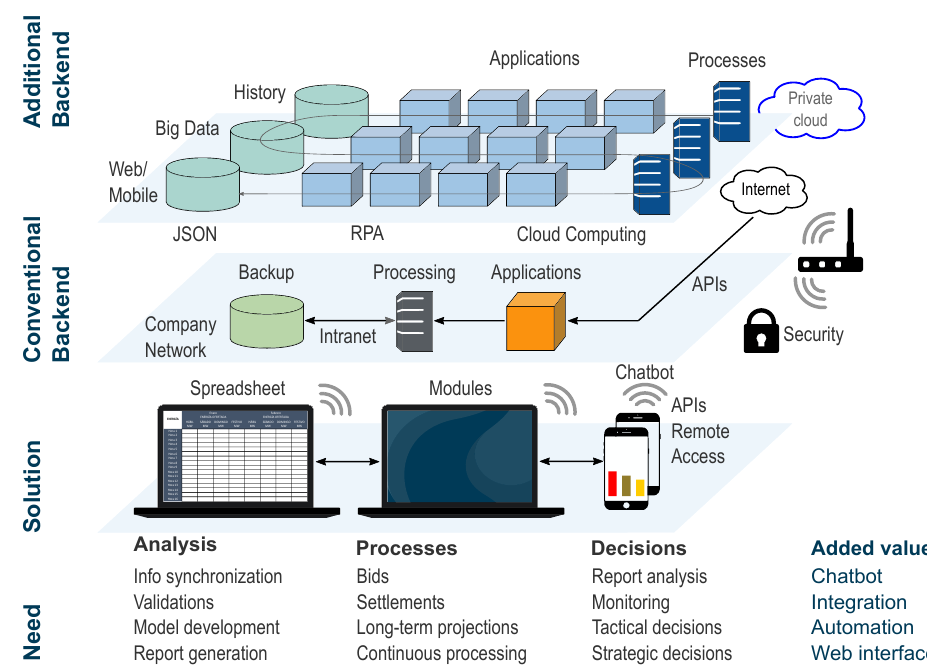
Figure 1. AES Colombia digital platform proposed